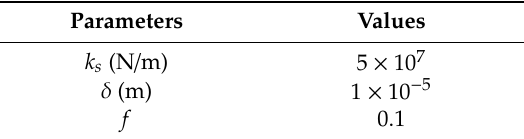
Table A4. The model parameters of rubbing.